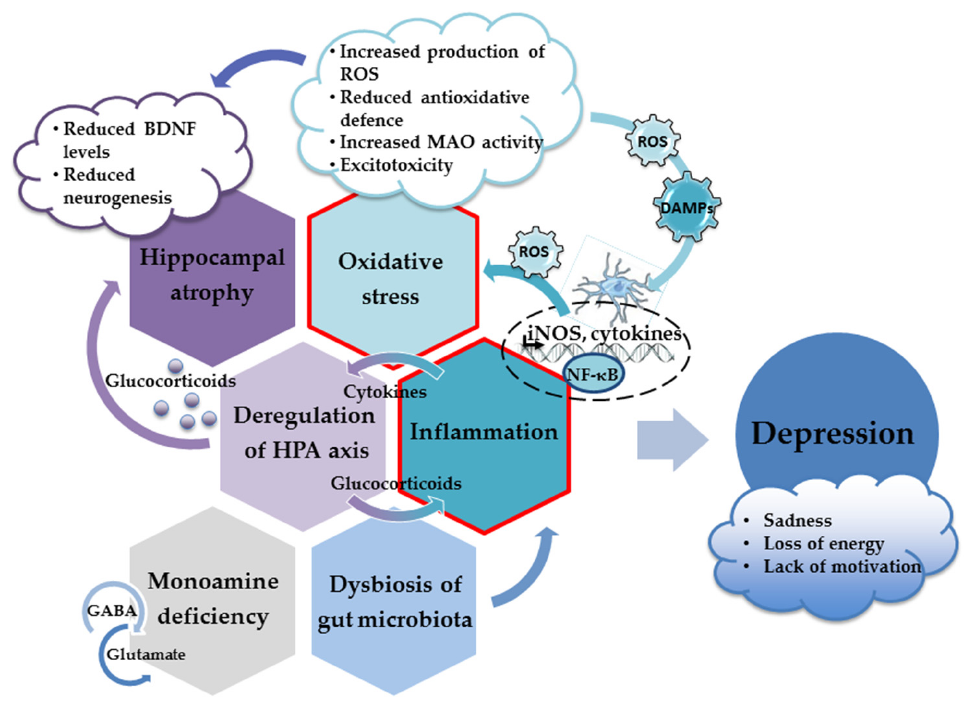
Figure 1. The main neuropathological mechanisms involved in the development of depression.